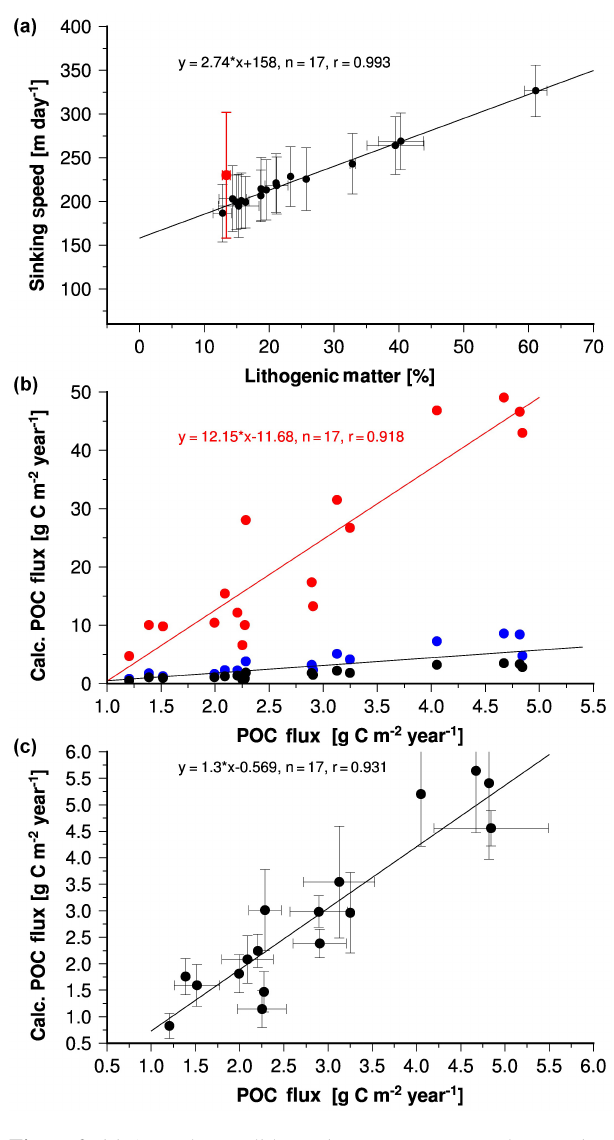
Figure 9. (a) Annual mean lithogenic matter content at the trap sites in the Indian Ocean versus sinking speeds derived from the sea- water properties and the density of the solids (Eqs. 6–9) including the regression equation and line. The red circle indicates sinking speeds derived from the US JGOFS sediment trap sites in the west- ern Arabian Sea (Berelson, 2001). (b) Annual mean organic carbon fluxes determined at the sediment trap sites versus organic carbon fluxes calculated by using Eq. (10) and sinking speeds shown in Fig. 9a. The export production was derived from Eqs. (1) (red cir- cles), (2) (blue circles) and (3) (black circles). Red shows the regres- sion equation and line obtained from the correlation between the calculated and measured fluxes, whereas the respective export pro- duction used to calculate the organic carbon flux was derived from Eq. (1). The black line indicates the 1 : 1 line. (c) Calculated versus measured fluxes as in Fig. 9b, but the modified Eq. (3) was used to calculate the required export production. The error bars indicate the interannual variability of the measured fluxes and the range caused the variability of the sinking speeds used to calculate the organic carbon flux.